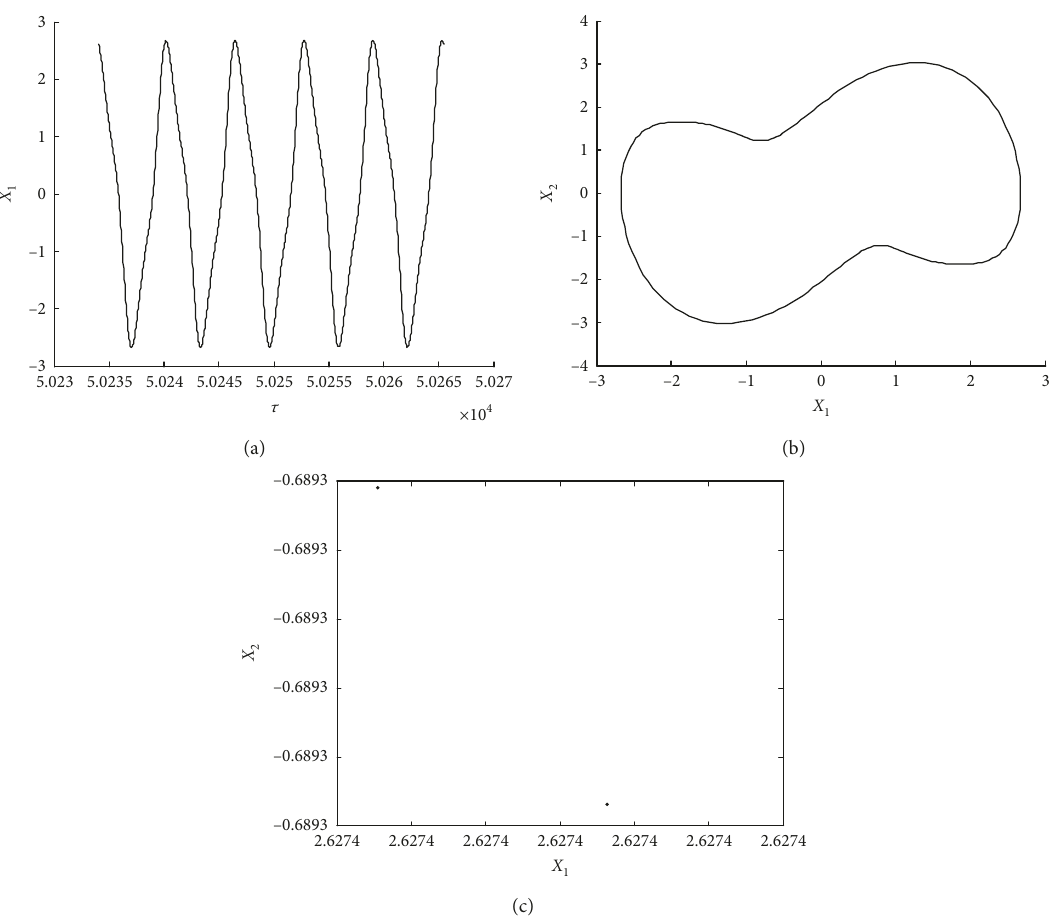
Figure 5: The periodic motion ( Ω � 2, ω � 1, c � 0.1, r � 0.5, p � 10, c (c) Poincar´e maps.